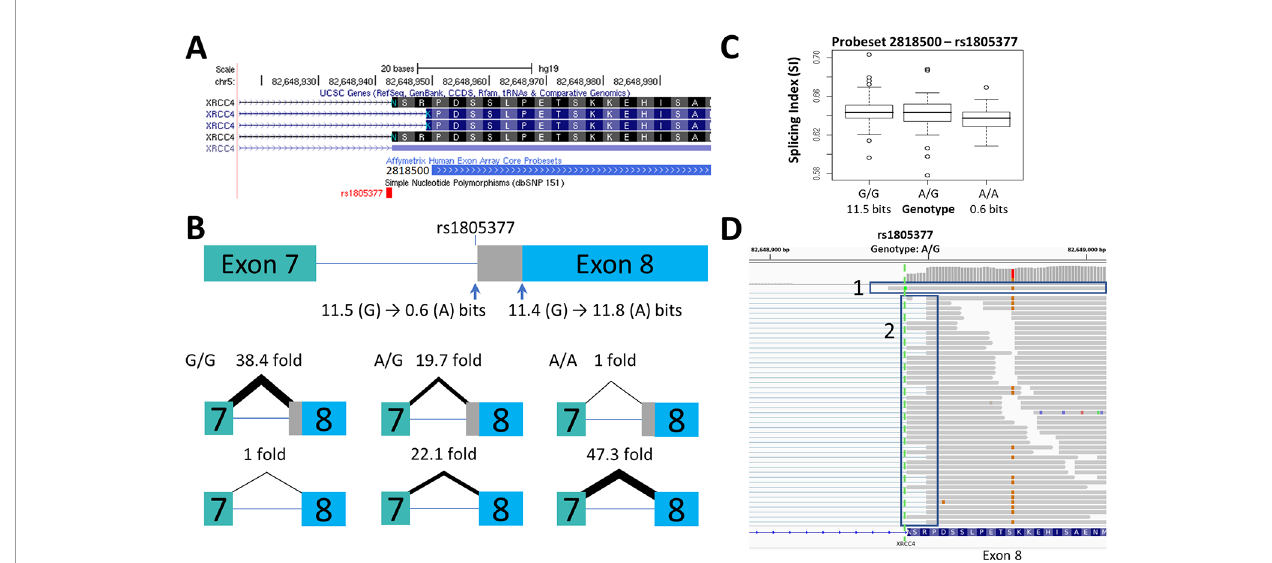
FIGURE 1 | Splicing Impact of rs1805377 ( XRCC4 ). The natural acceptor of XRCC4 exon 8 is abolished by rs1805377 (11.5 − > 0.6 bits) while simultaneously strengthening a second exonic cryptic acceptor 6nt downstream (11.4 to 11.8 bits), resulting in a 6nt deletion in the mRNA. (A) Both of these acceptor sites have been validated in GenBank mRNAs, i.e., NM_022406 and NM_003401 (UCSC panel derived from http://genome.ucsc.edu). (B) The relative abundance of the two splice forms was determined by q-RT-PCR. The weaker rs1805377 A/A genotype (0.6 bit acceptor) was used ~47-fold less frequently than the cryptic downstream acceptor (11.8 bits). (C) The two splice isoforms cannot be distinguished by the exon microarray as the upstream probeset (ID 2818500) does not overlap the variable region, though the average expression of the rs1805377 A/A genotype is reduced. (D) ValidSpliceMut fl agged this mutation for intron retention, which can be observed in the RNAseq of heterozygous ICGC patient DO27779 [Box 1]. Use of both acceptor sites is also evident [Box 2]. For more detail for this and all of the other single nucleotide polymorphisms (SNPs) analyzed, refer to Supplementary Image 1